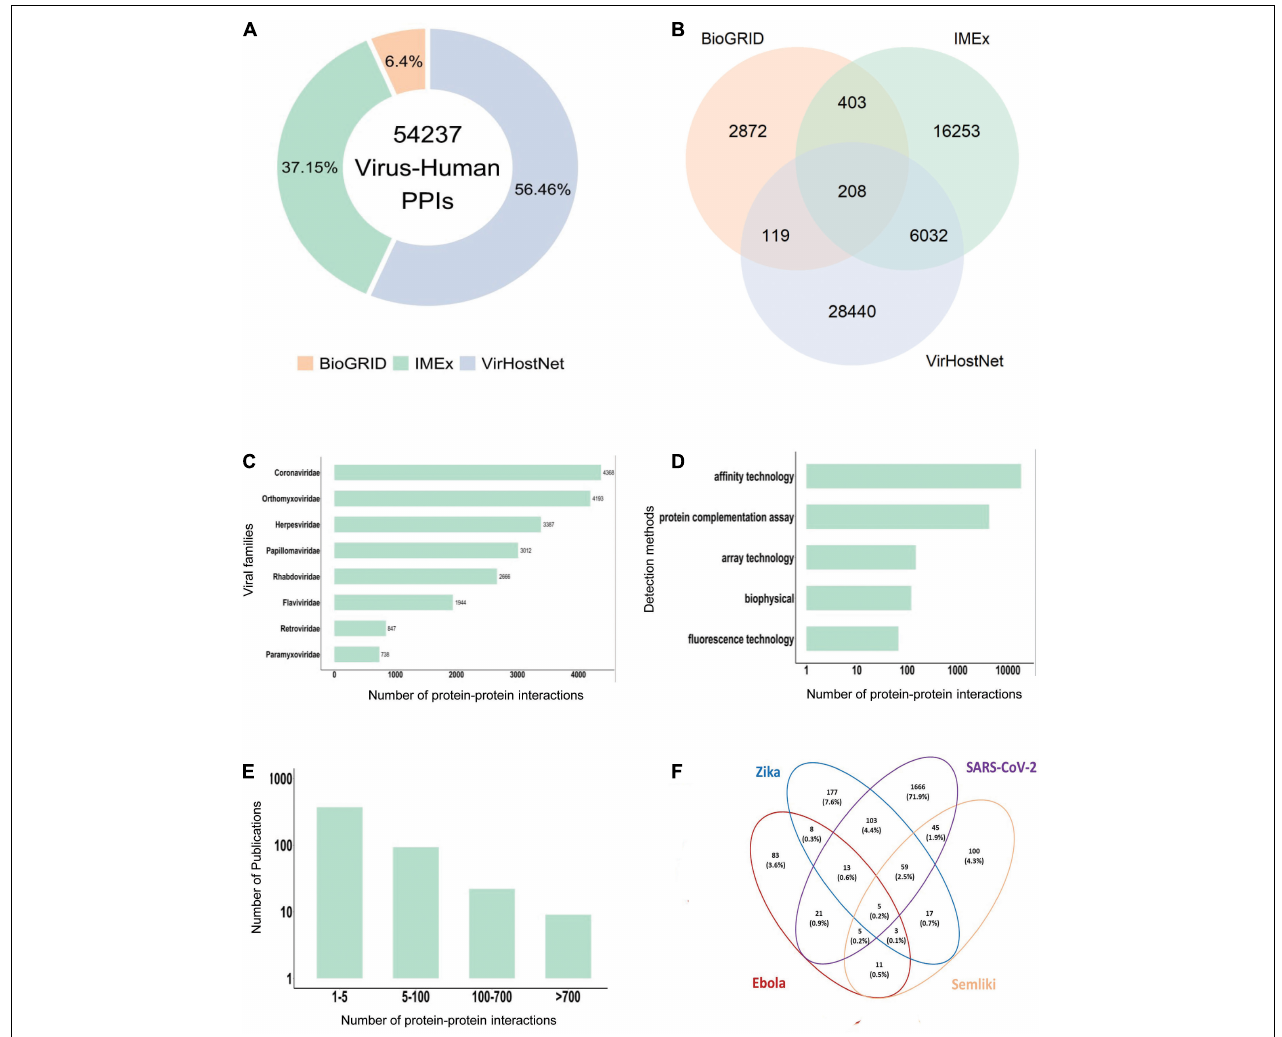
FIGURE 1 | Virus-human protein-protein interaction data statistics. (A) Virus-Human PPI data from the three major primary interaction resources (August 2021, BioGRID: 3,943 interactions, IMEx: 22,896 interactions; VirHostNet: 34,799 interactions). (B) PPI data overlap among BioGRID, IMEx and VirHostNet databases. (C) Number of PPIs in the IMEx dataset for the most representative viral families. (D) Number of PPIs in the IMEx dataset according to the experimental methods used for the interaction detection. Methods were grouped in broad categories. For instance, yeast two-hybrid is considered a “protein complementation assay,” and pull-down and coimmunoprecipitation belong to the “affinity technology” category. (E) Number of detected PPIs in each paper curated in the IMEx dataset. Most papers describe less than 5 interactions and very few contain more than 100 interactions. The Y-axis is log-transformed. (F) Human targets overlap in the PPI network of four emerging viruses. Percentages are computed over the union of all the